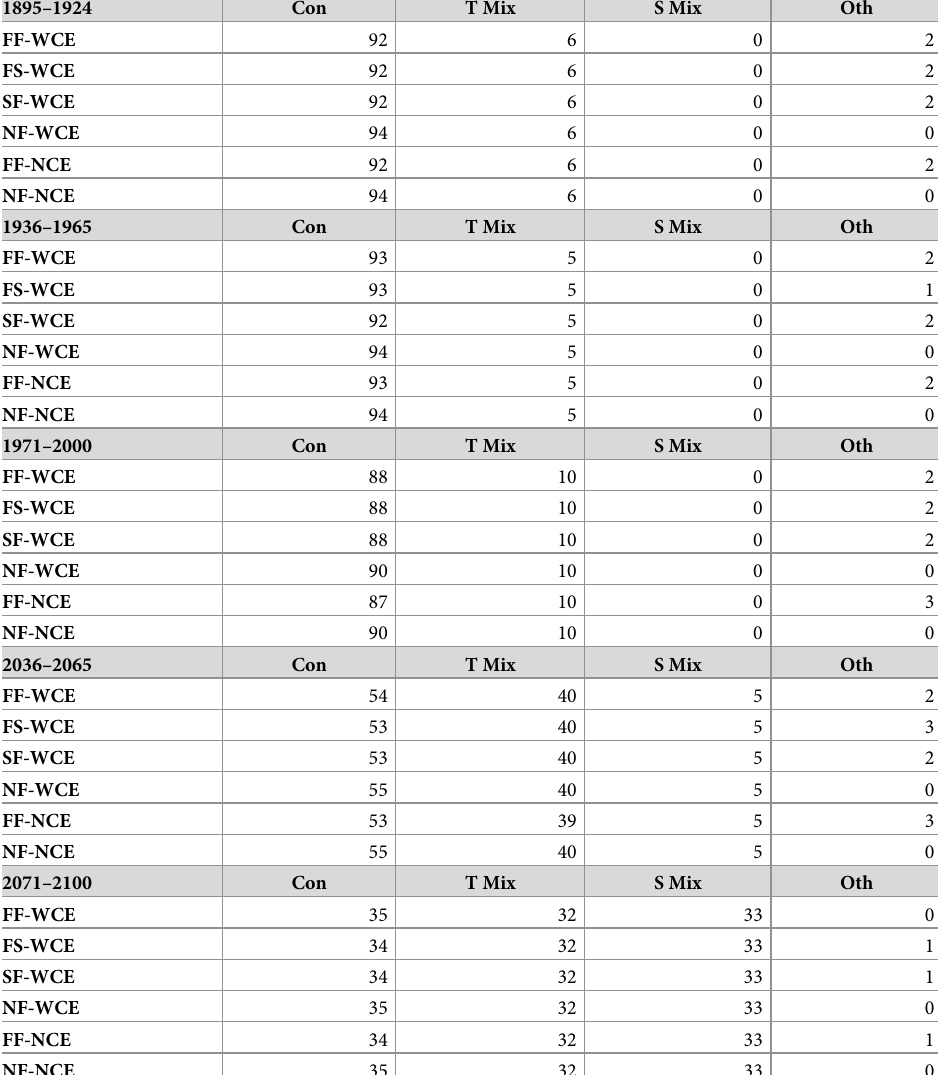
Table 8. Simulated vegetation composition (%) of study